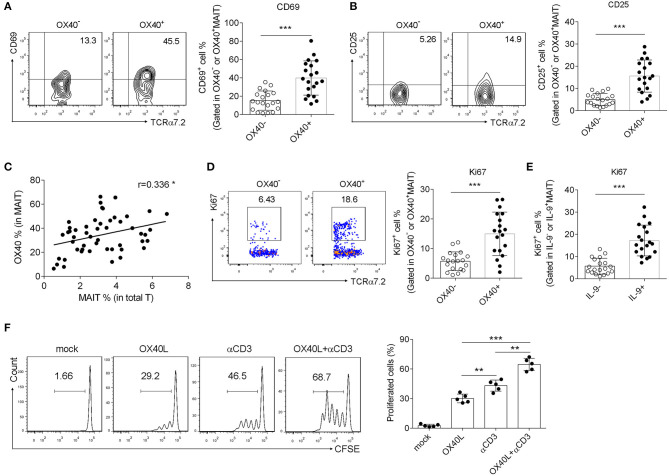
OX40 facilitated MAIT cell activation and proliferation in H. pylori infection. Gastric mucosa from H. pylori-positive patients (n = 20) was collected. (A) CD69 and (B) CD25 expression in OX40− and OX40+ MAIT cells was determined by flow cytometry. (C) The correlation between OX40 expression in MAIT cells and the percentage of MAIT cells in total T cells was evaluated. Proliferation of (D) OX40+ and OX40− MAIT cells, as well as (E) IL-9+ and IL-9− MAIT cells were assessed, and reflected by the intensity of Ki67. (F) MAIT cells were isolated from the gastric mucosa of H. gastritis patients (n = 5) and stimulated with 1 μg/ml CD3 Abs or 10 μg/ml recombinant OX40L for 3 days. Proliferation of MAIT cells was determined, as represented by the fluorescence intensity of CFSE. Data represented the mean ±S.D from at least three independent experiments. Unpaired Student's t-test was used to compare the difference between HC and gastritis group. One way ANOVA was performed to compare multiple groups. **P < 0.01; ***P < 0.001.